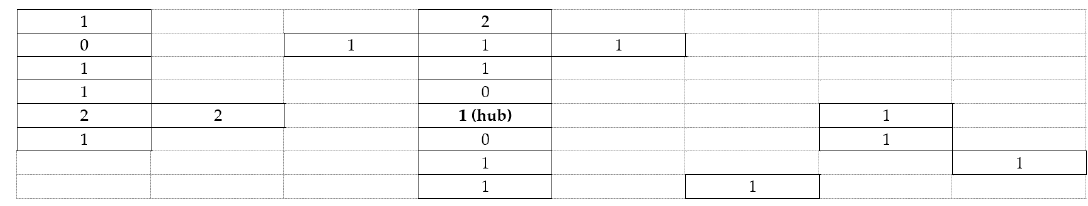
Figure 7. Quadrat analysis of Munkács. Source: Author.